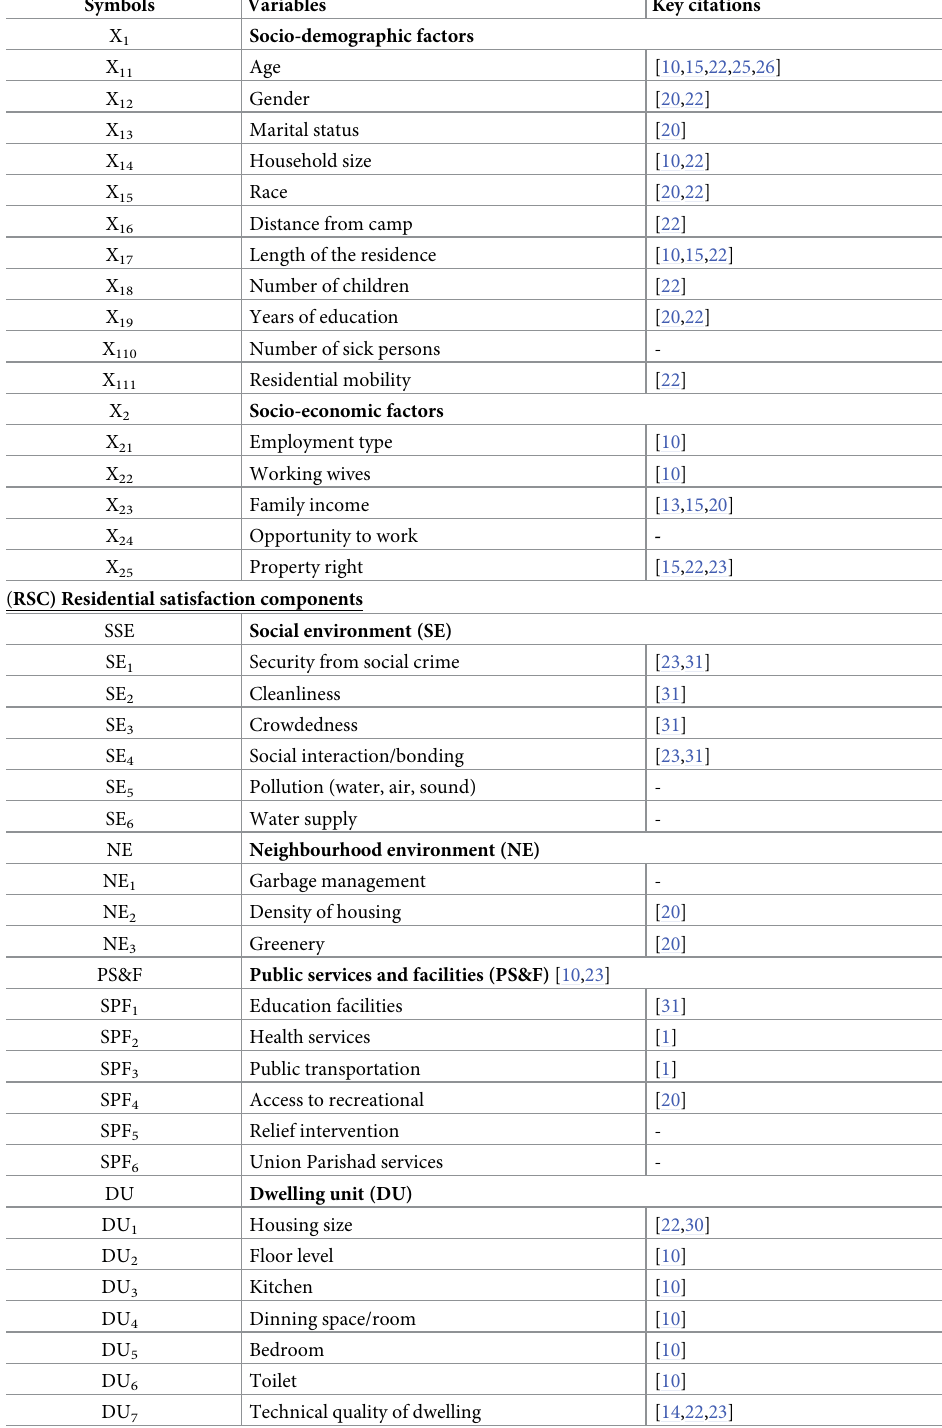
Table 2. Key indicators of residential